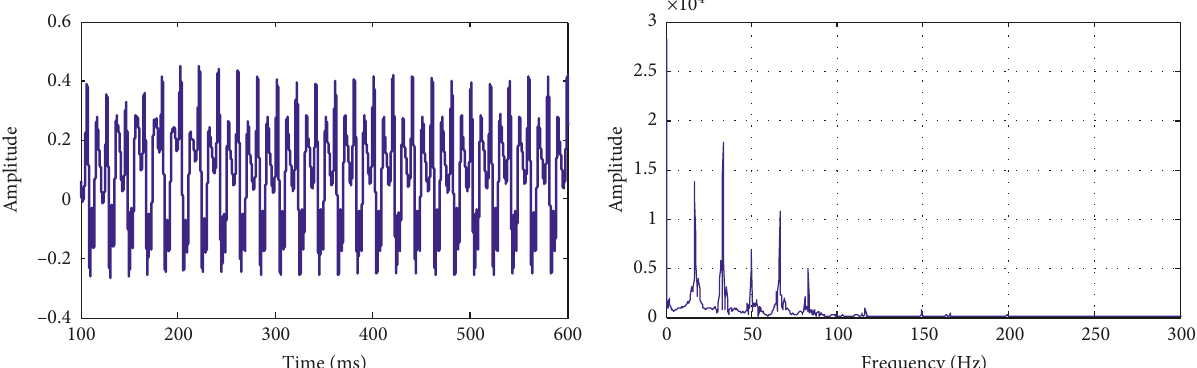
Figure 8: Vertical vibration amplitude signals and its frequency diagram on left